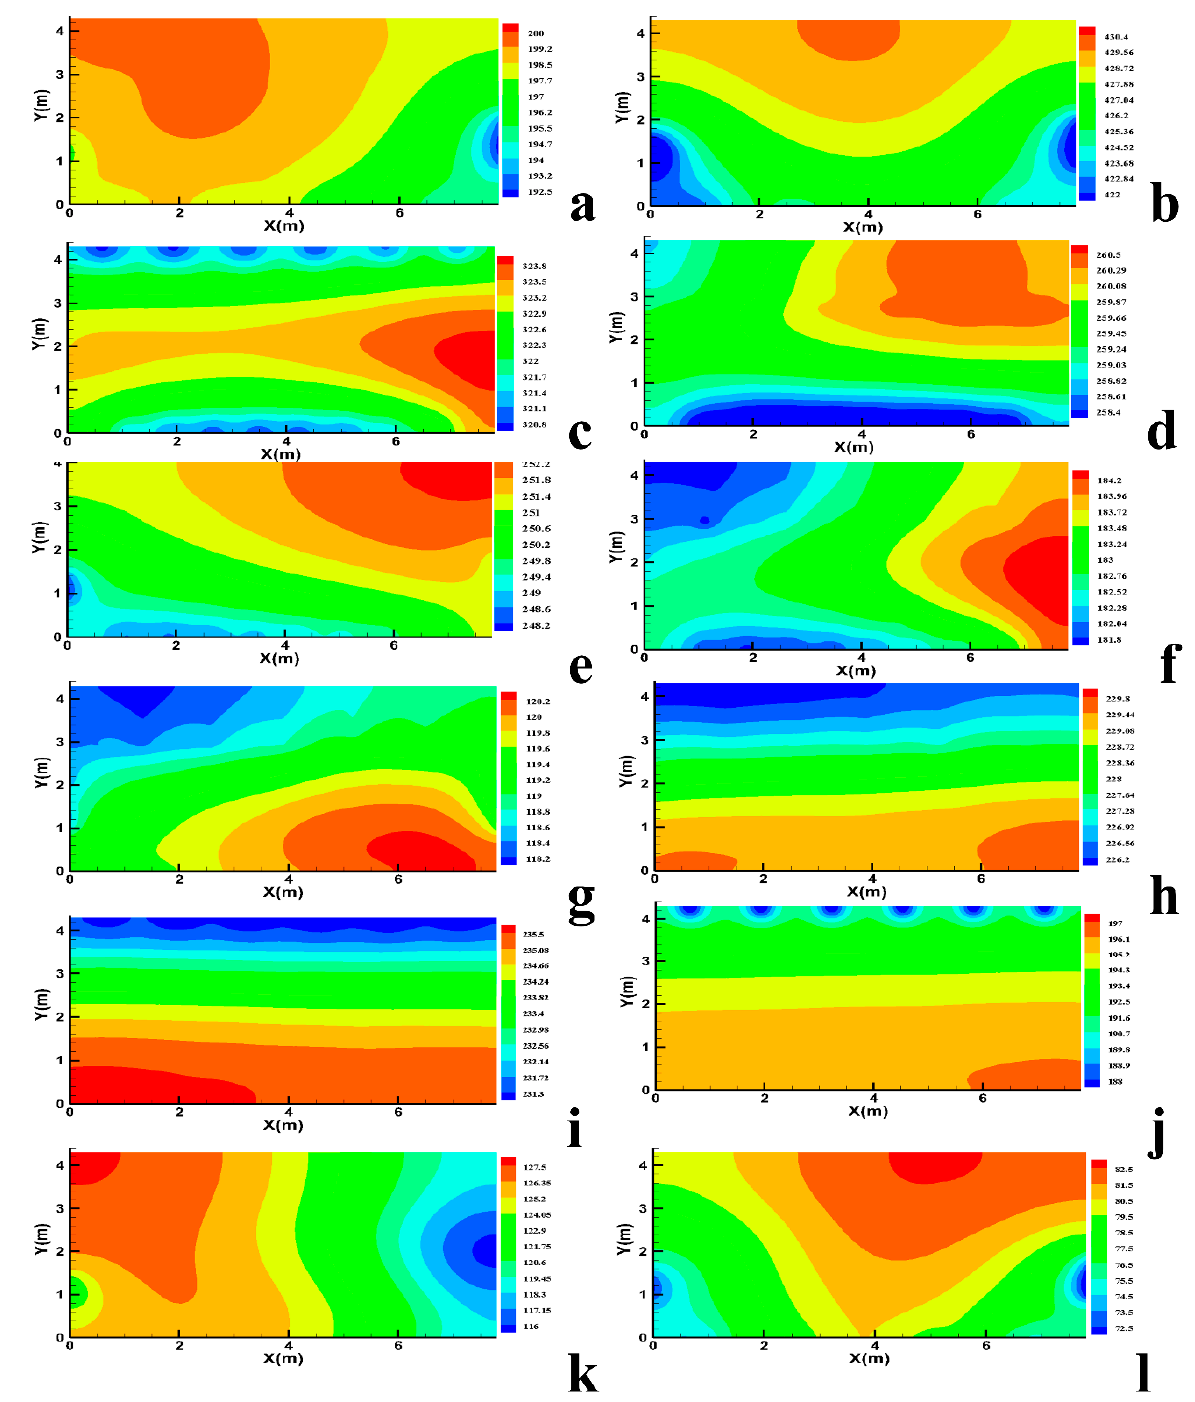
Figure 12. Air age cloud diagrams of different scenarios (ACH = 15), ( a – l ) MV-1 – IJV-7. When the ACH is 20, the maximum and minimum values of AEE are 7.2165 (PV-3) and 1.4995 (IJV-7), respectively, and the AEE of the other schemes is less than 7 (Figure